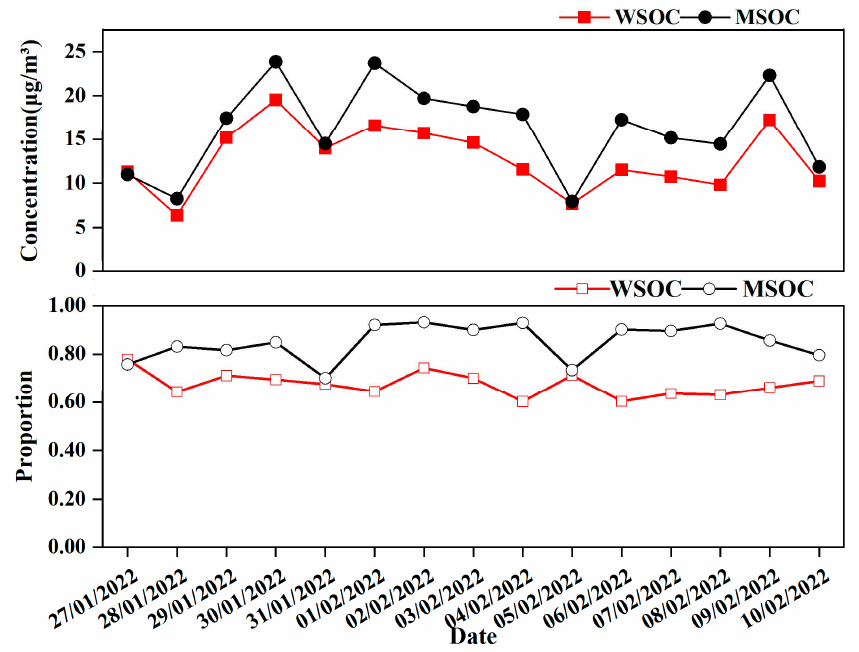
Figure 6. Variations of WSOC and MSOC concentrations and their proportion in TOC.